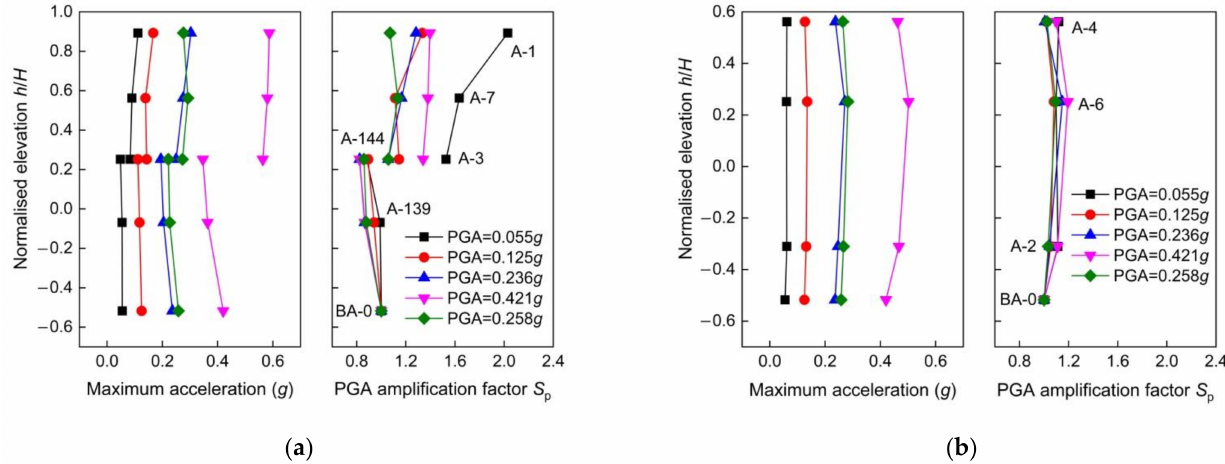
Figure 6. Maximum acceleration distributions along the normalized slope elevation in the 2# model in centrifuge tests: ( a ) deposit surface; ( b ) bedrock